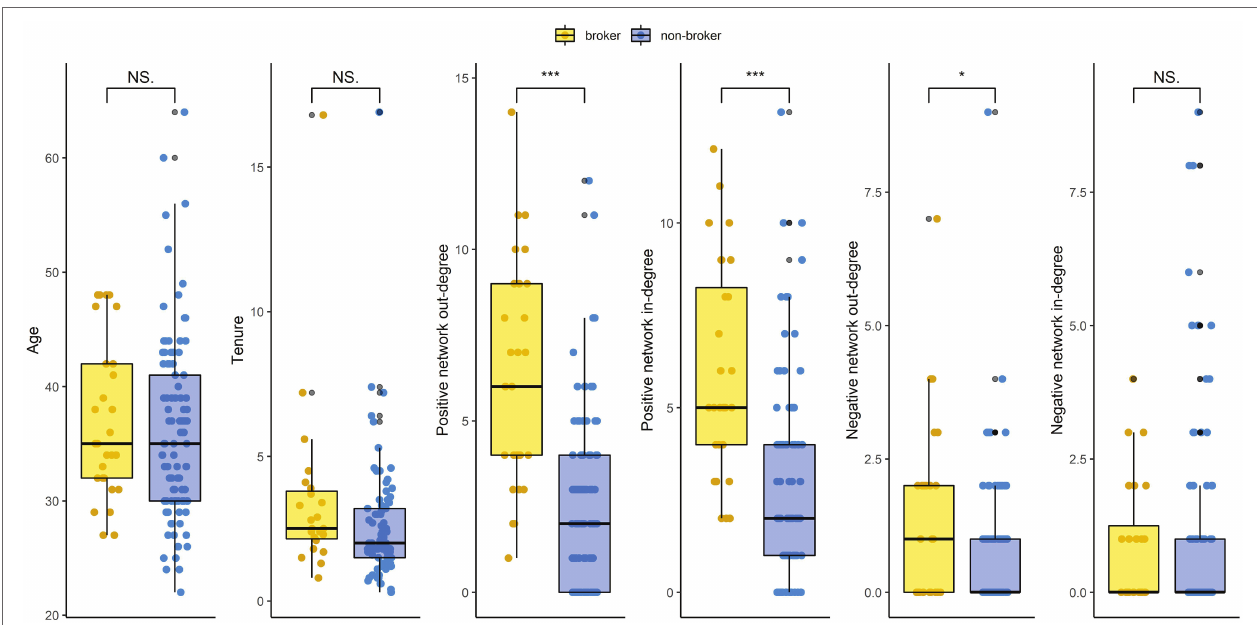
FIGURE 3 | Comparison between brokers and non-brokers. NS. non-significant, * p < 0.05, ** p < 0.01, and *** p < 0.001.